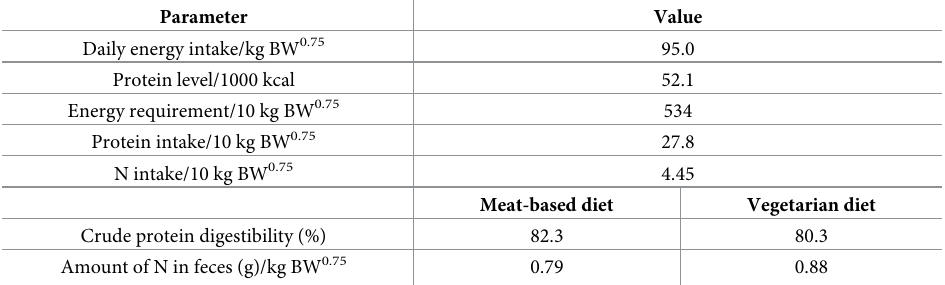
Table 4. Amount of N excretion in feces of dogs fed experimental diets according to FEDIAF [30].